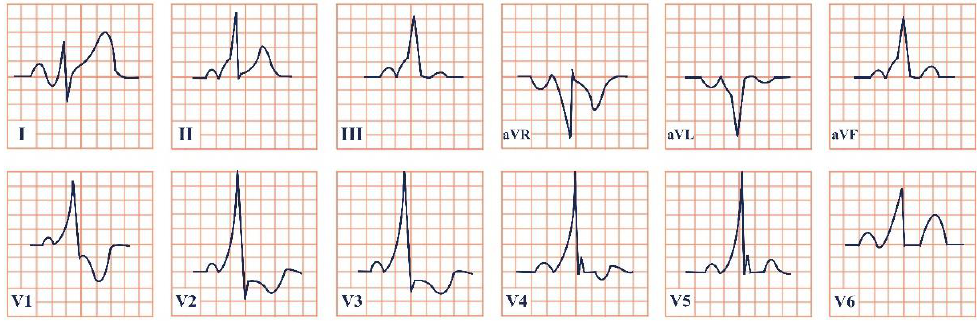
Figure 6. Electrocardiogram aspect in Wolff – Parkinson – White